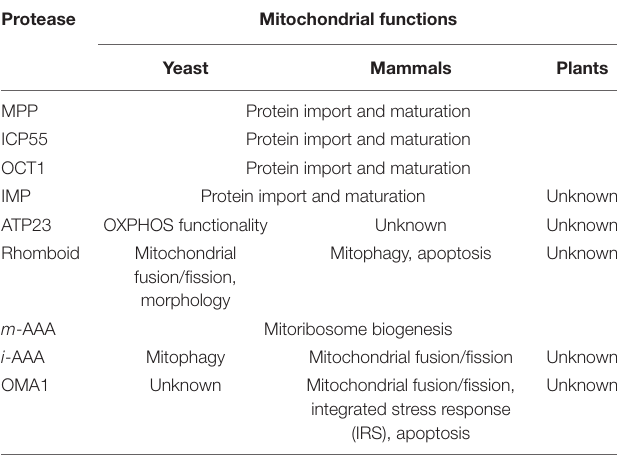
TABLE 3 | Mitochondrial processes regulated by limited proteolysis in yeast, mammalian, and plant